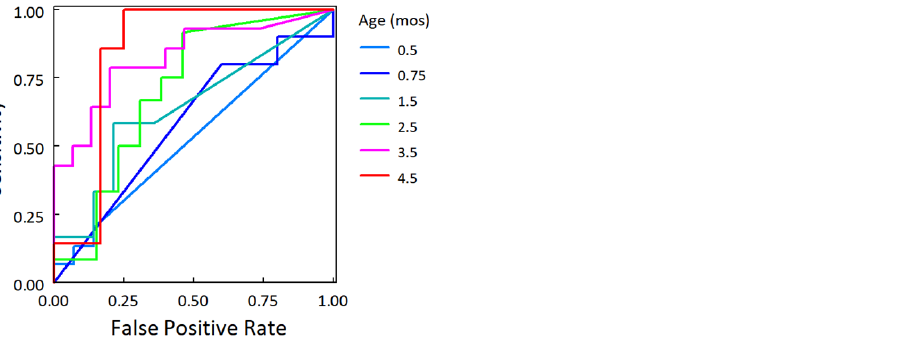
Figure 4. Heatmap of bacterial species from 0.5 to 4.5 months in CMF (red bar) and EHF (black bar) groups. Red signifies higher abundance. Linear mixed effects models revealed significant group × time, group and time effects (blue) for Steptococcus thermophiles and significant group × time and time effects (orange) for Ruminococcus gnavus , Blautia producta , Ruminococcus torques , Clostridium nex- ile , Flavonifractor plautii , and Anaerotruncus colihominis.